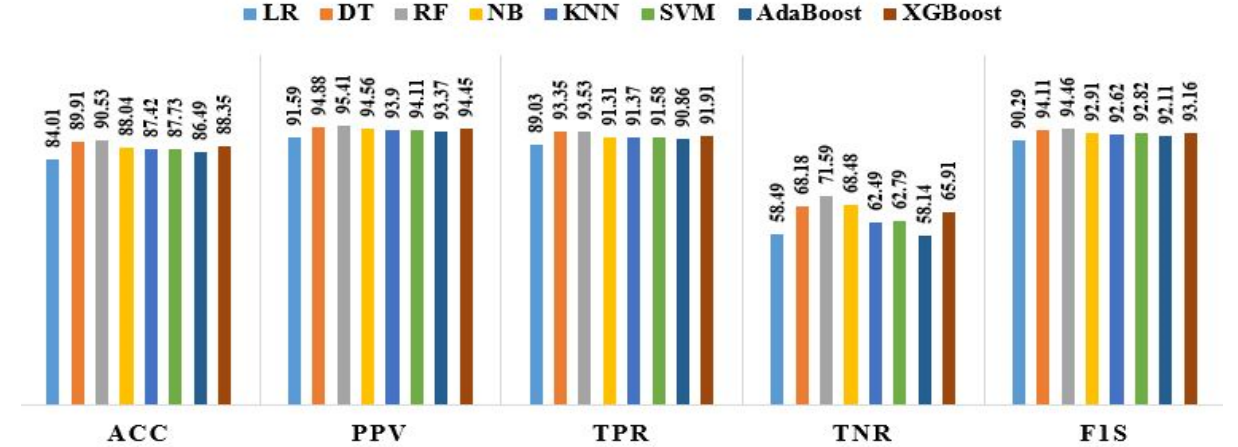
Table 7. Recorded results of performance parameters based on various proposed approaches.